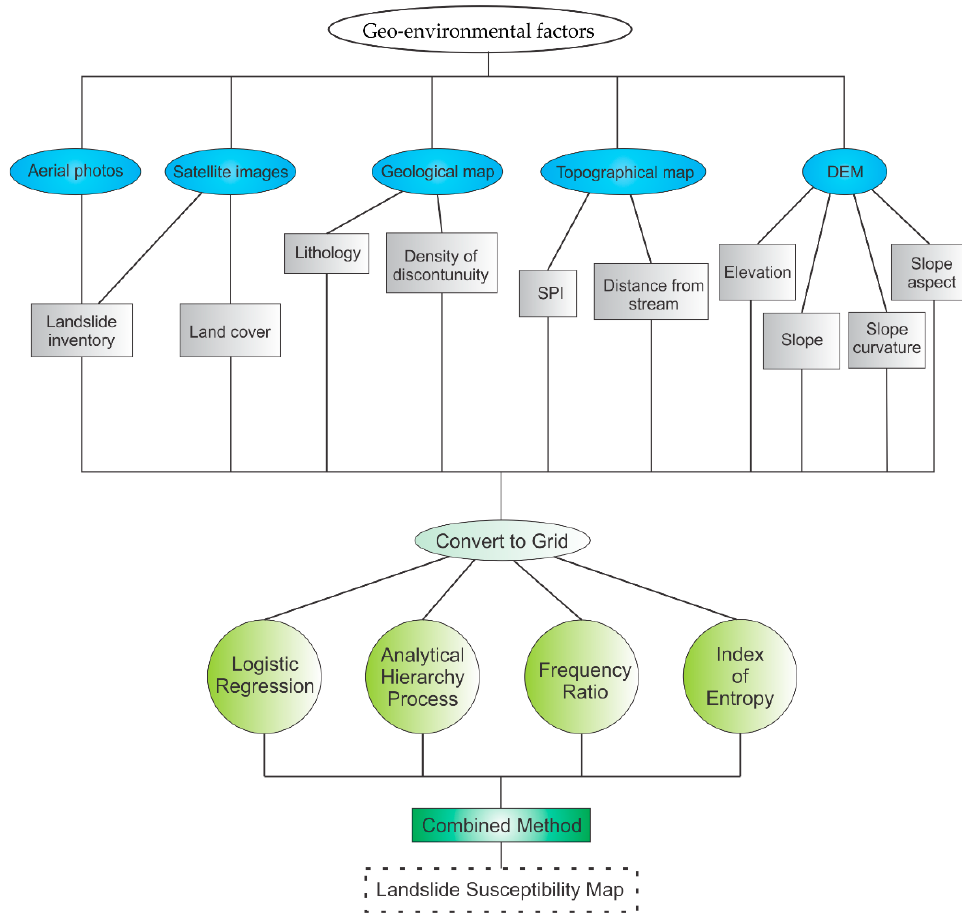
Figure 2. Different steps of combined landslide susceptibility mapping preparation.